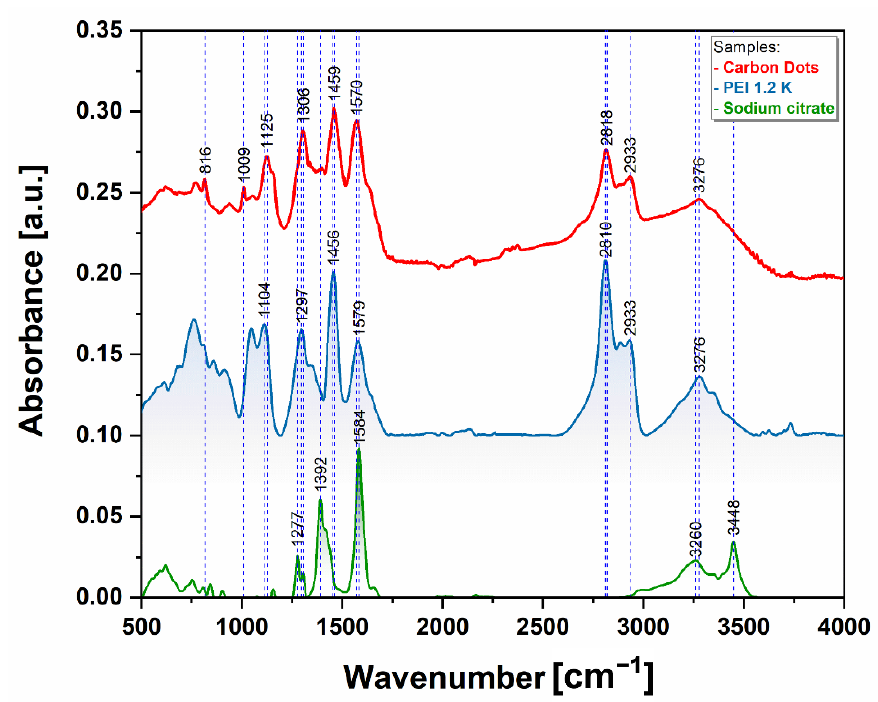
Figure 11. FTIR spectra of the CQDs (red) and of the precursors, sodium citrate (green) and PEI 1.2 (blue) in the spectral range 400–4000 cm − 1 . The spectra were baseline corrected, normalized, and K (blue) in the spectral range 400 – 4000 cm −1 . The spectra were baseline corrected, normalized, and vertically shifted for better clarity. vertically shifted for better clarity.